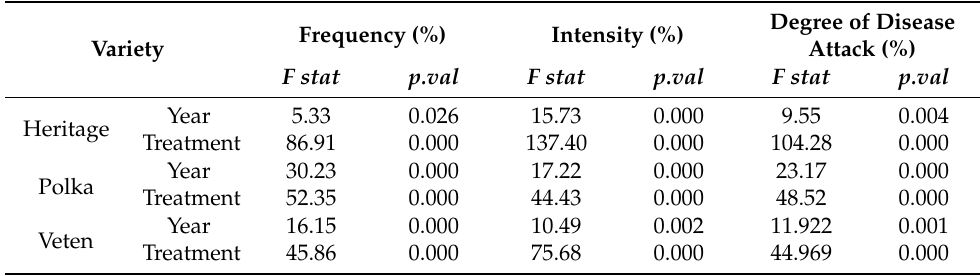
Table 8. Annual interaction between raspberry varieties and applied treatments against rust disease. ANOVA test for differences ( p <